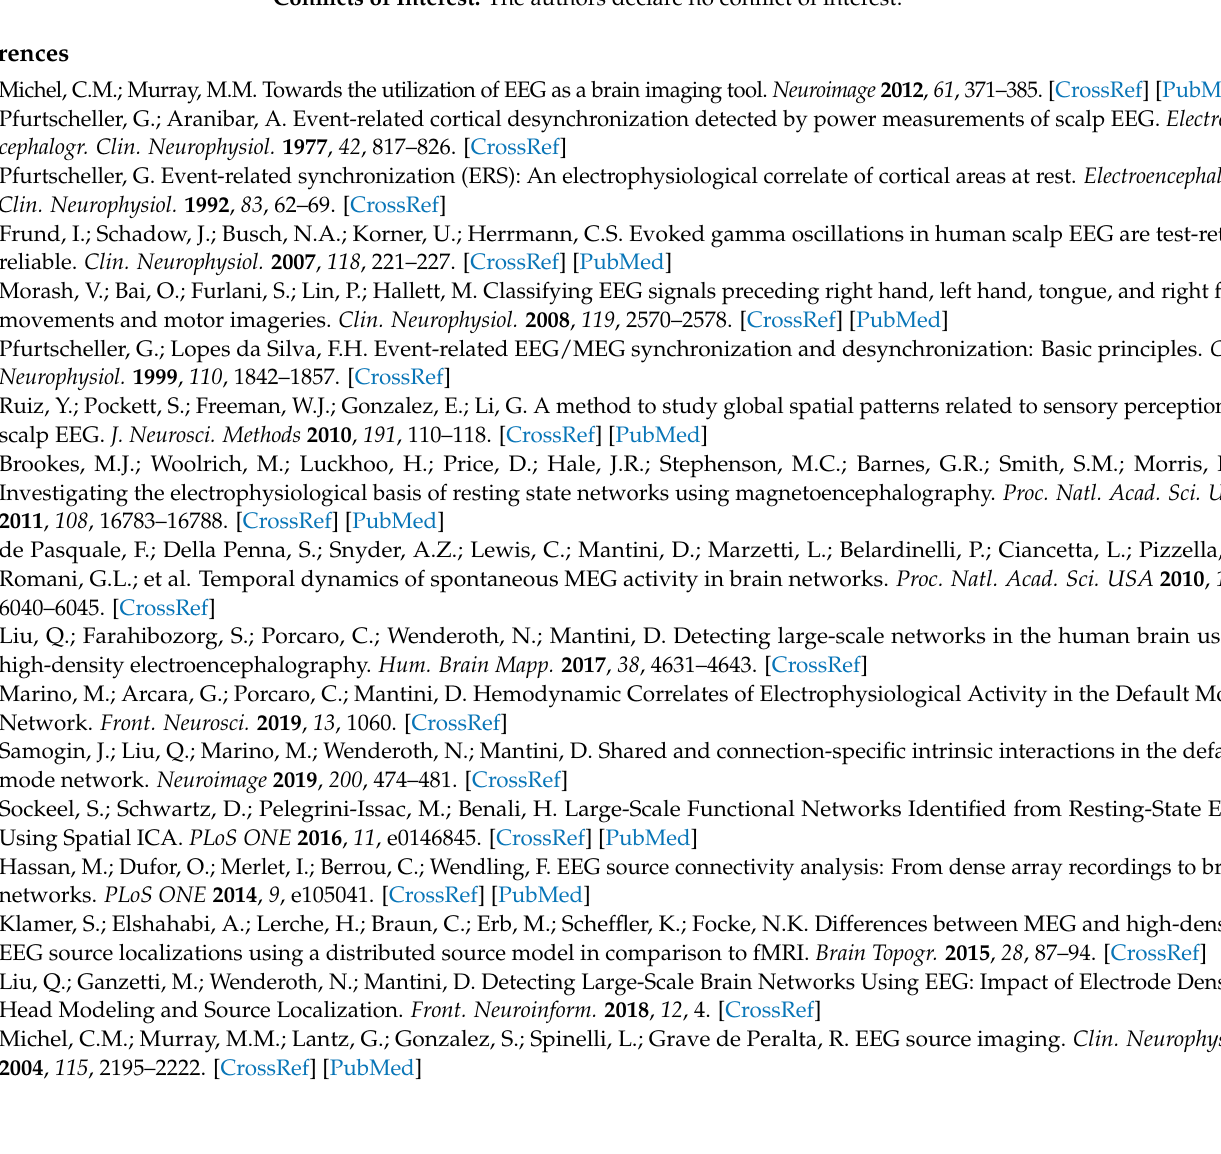
models; Figure S6: Scatterplots of intra- and inter-network connectivity differences for different head models, compared to the corresponding values obtained using the reference analysis